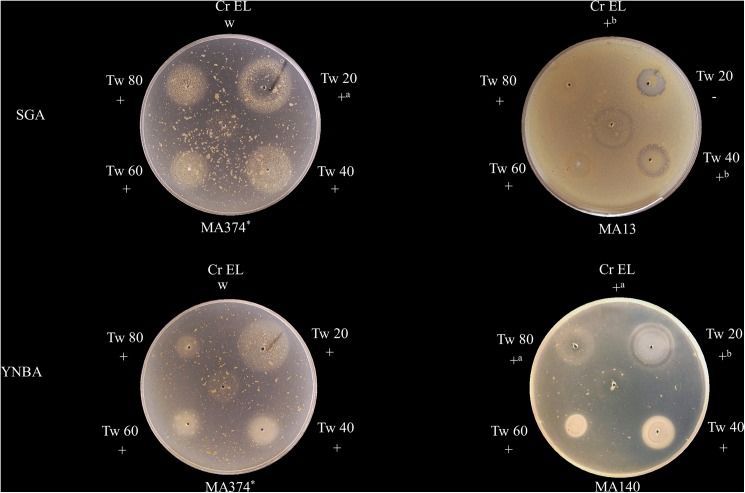
Growth patterns of M. pachydermatis strains in the Tween diffusion test with SGA and YNBA, after 7 days of incubation at 32°C.The growth patterns were defined as good growth (+); weak growth (w); growth at a distance of the well where the substrate was placed (+a); ring of growth inhibition at a distance of the well (+b); growth inhibition (-); *: lipid-dependent strain.